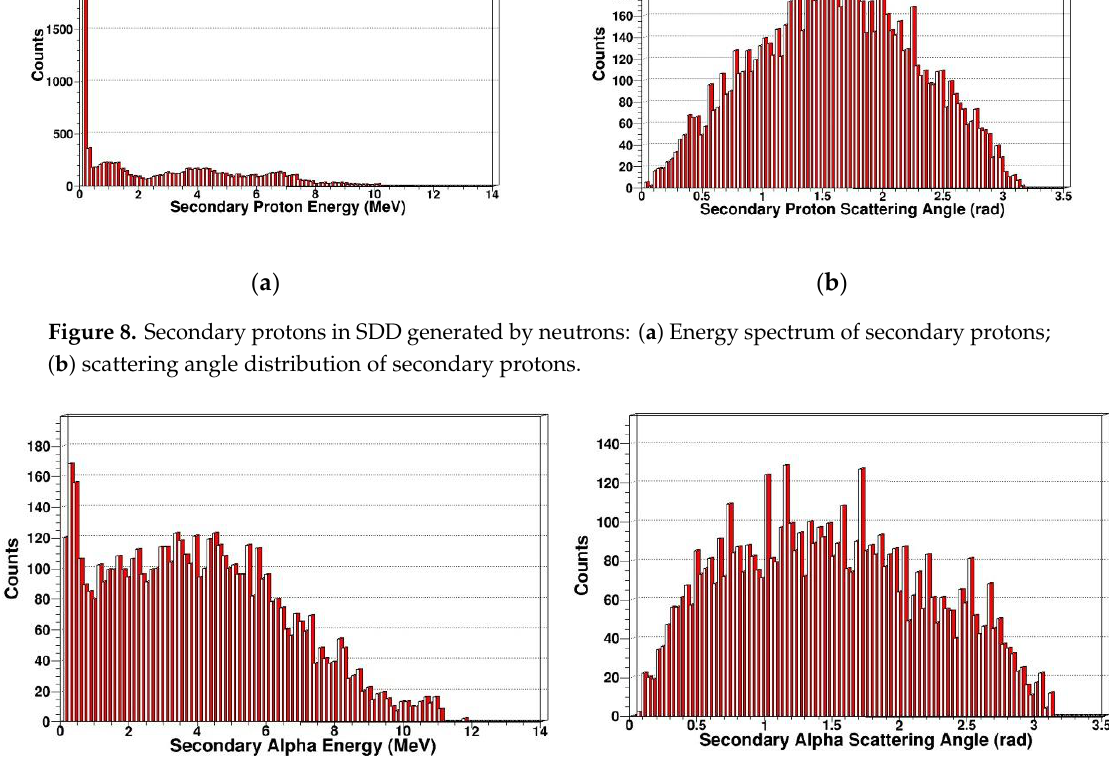
Figure 8. Secondary protons in SDD generated by neutrons: ( a ) Energy spectrum of secondary protons; ( b ) scattering angle distribution of secondary protons.